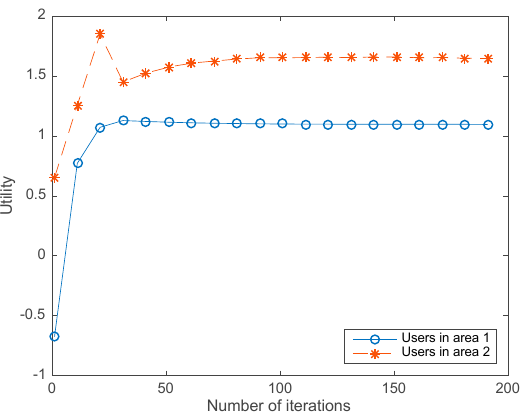
Figure 6. Utility of the mobile user in either area 1 or area 2 with the number of iterations.